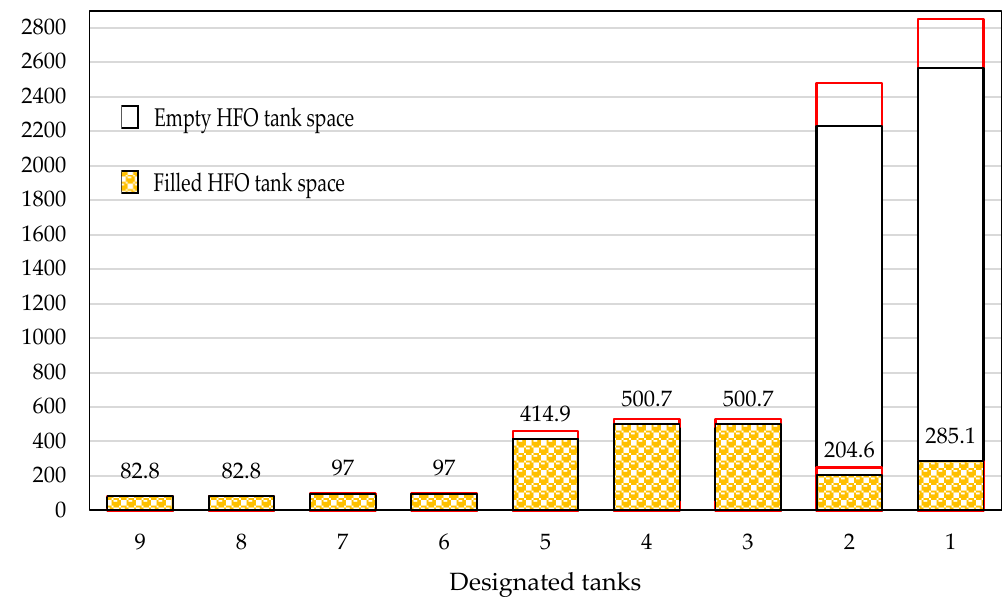
Figure 6. HFO bunker condition before bunker loading for the second example.